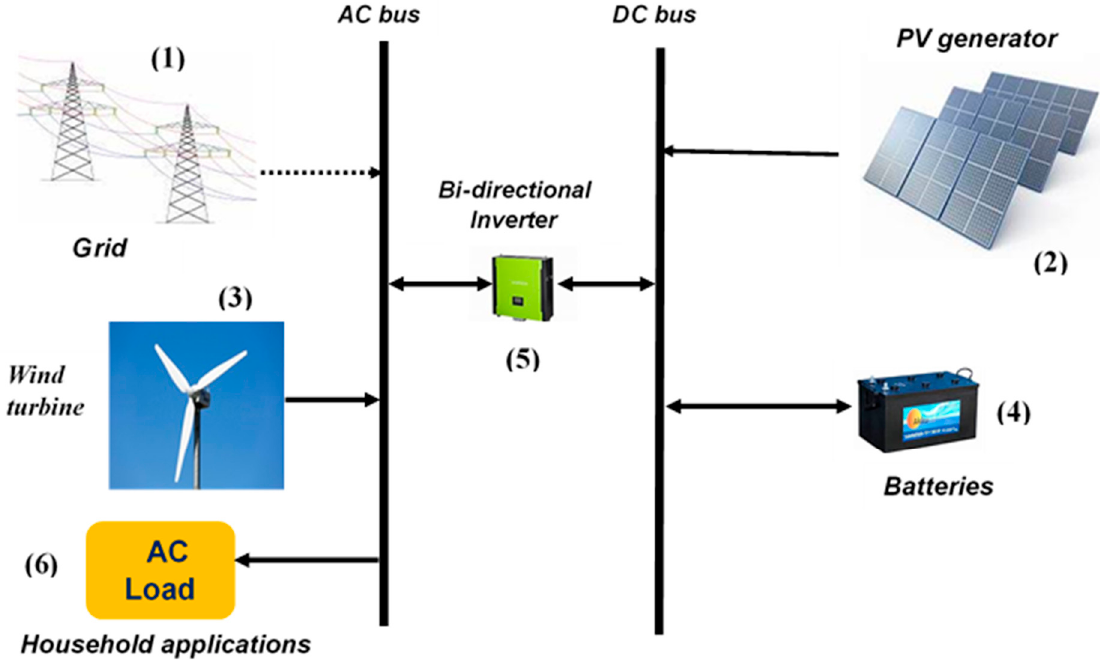
Figure 2. Main configuration of the studied systems.